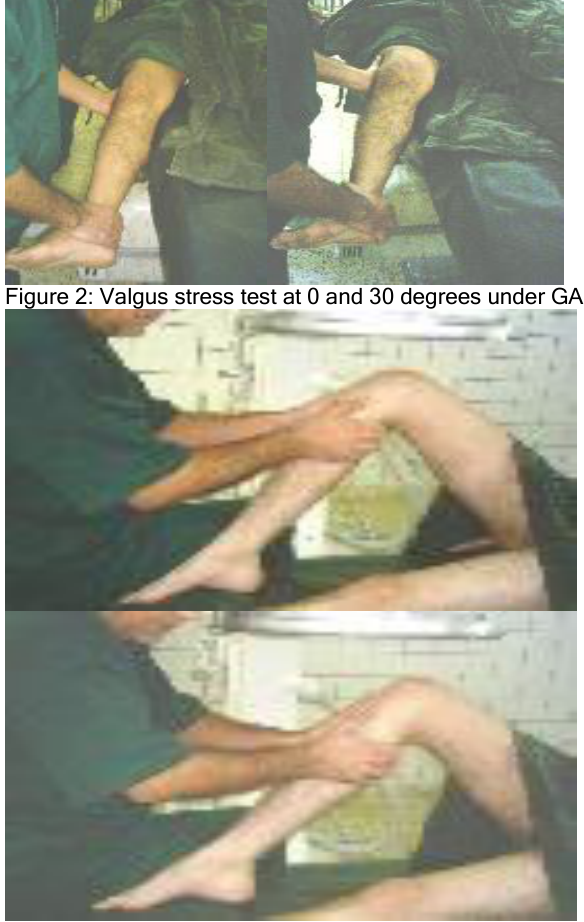
Figure 3: Anterior and posterior Drawer test under GA. Results: All the data collected from the patients are